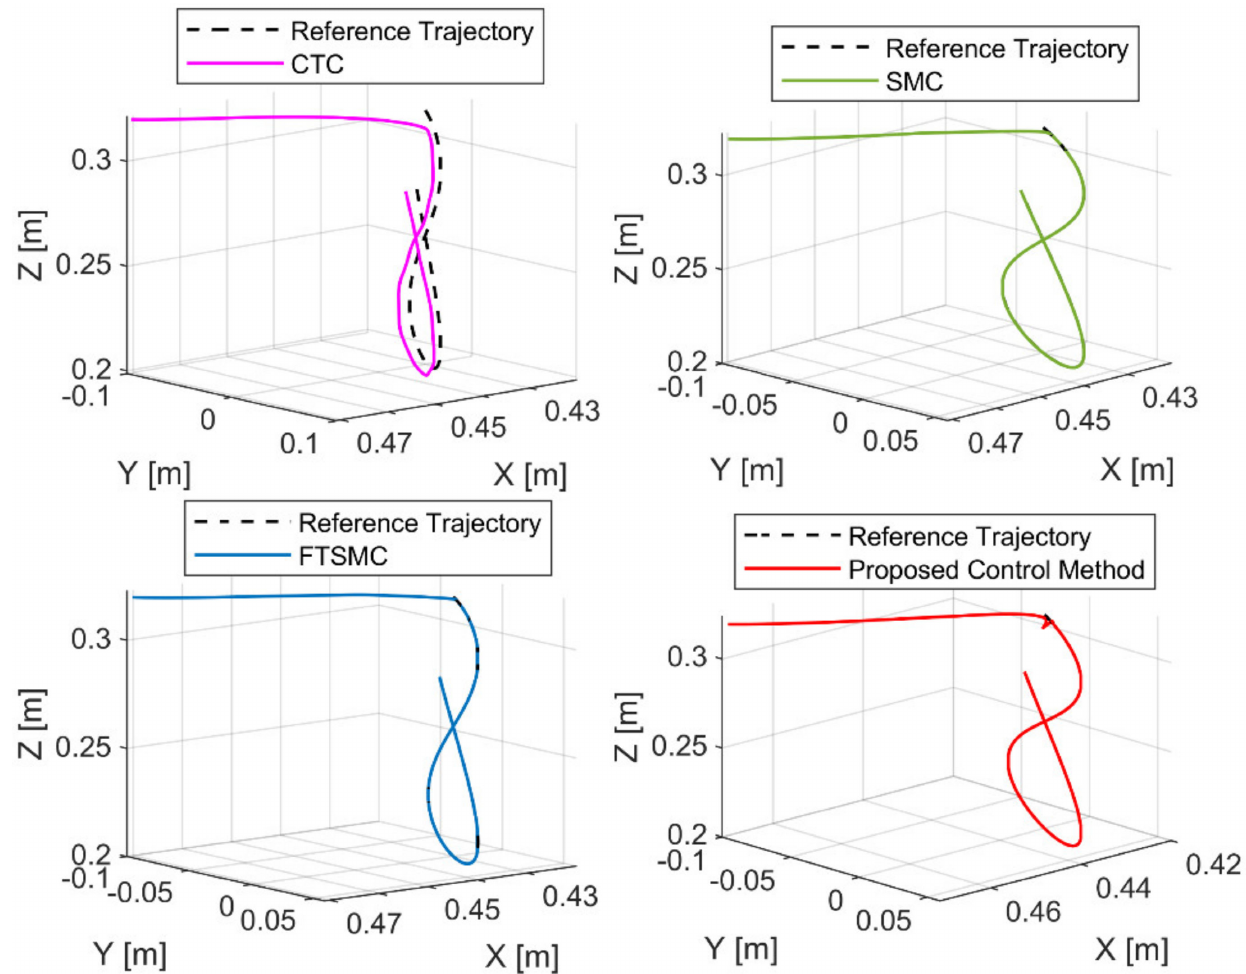
Figure 4. The reference trajectory and real trajectory of the end-effector under four